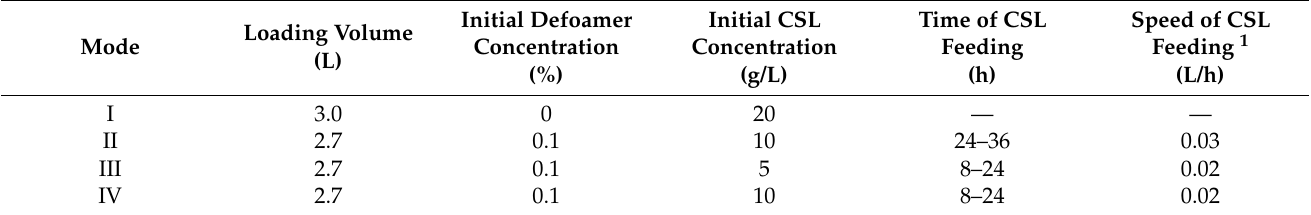
Table 1. Methods of feeding organic nitrogen source in S. pararoseus fed-batch